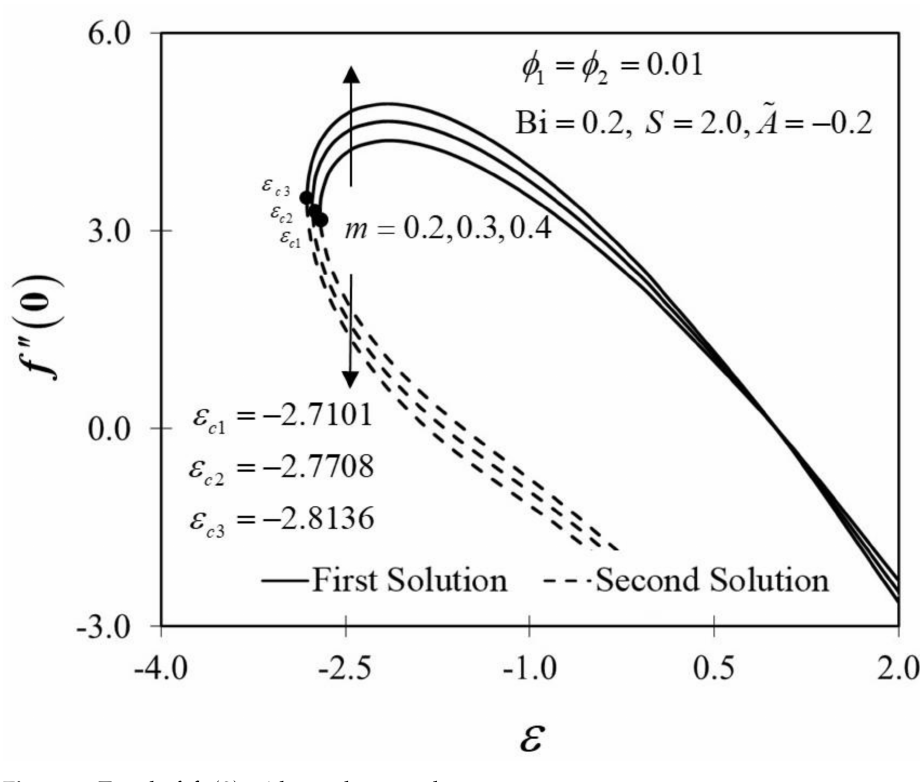
Figure 6. Trend of f (cid:48)(cid:48) ( 0 ) with ε and assorted m .